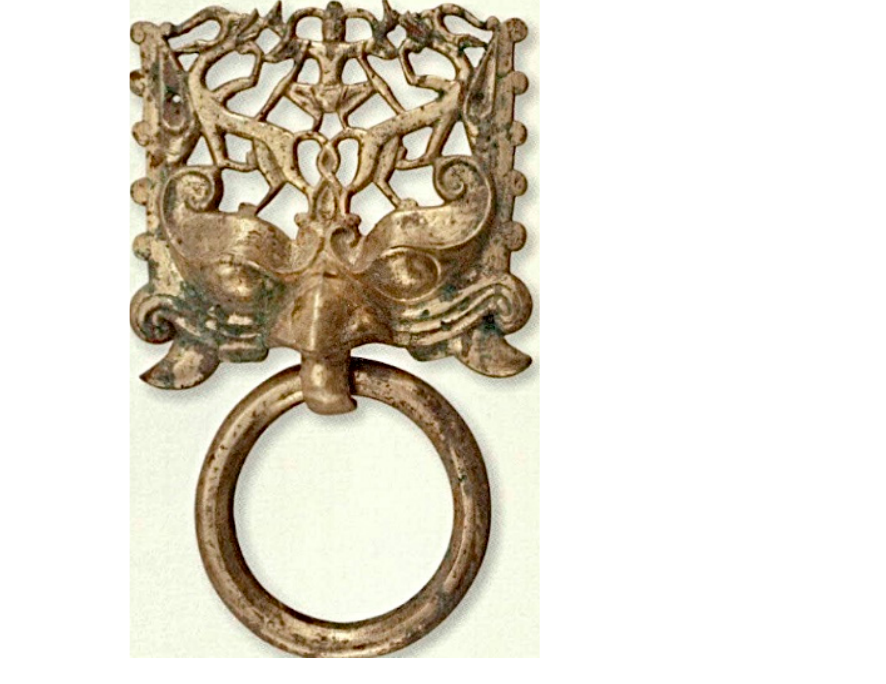
Figure 12. Pushou with human–animal juxtaposition, gilt bronze, excavated from Yihe’nur M1, Inner Mongolia, fifth century; after (Chen et al. 2016), Figure 13.